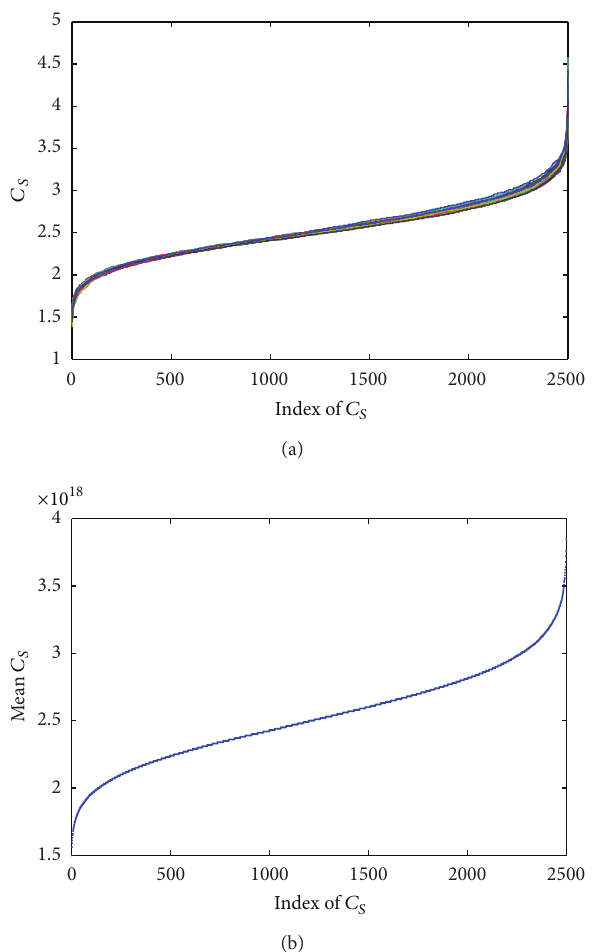
Figure 3: (a) The subgraph centrality 𝐶 𝑆 (𝑖) curves of the WS small- world network, (b) mean subgraph centrality ⟨𝐶 𝑆 (𝑖)⟩ curve of the WS small-world network.